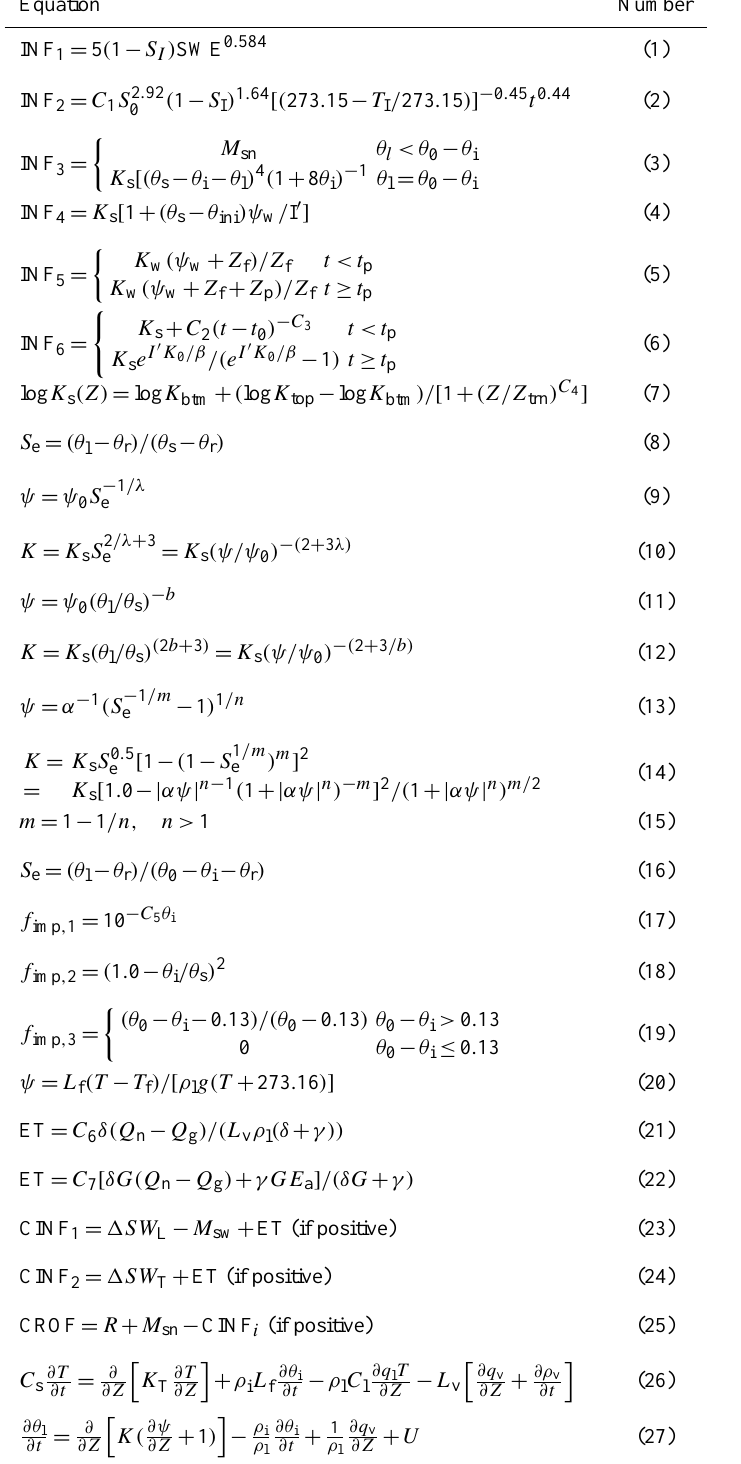
Table 1. List of